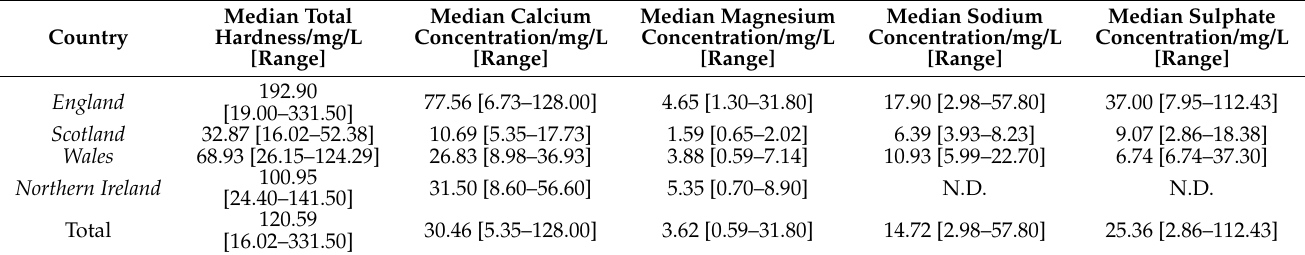
Table 1. Comparison of water composition by country in the United Kingdom.